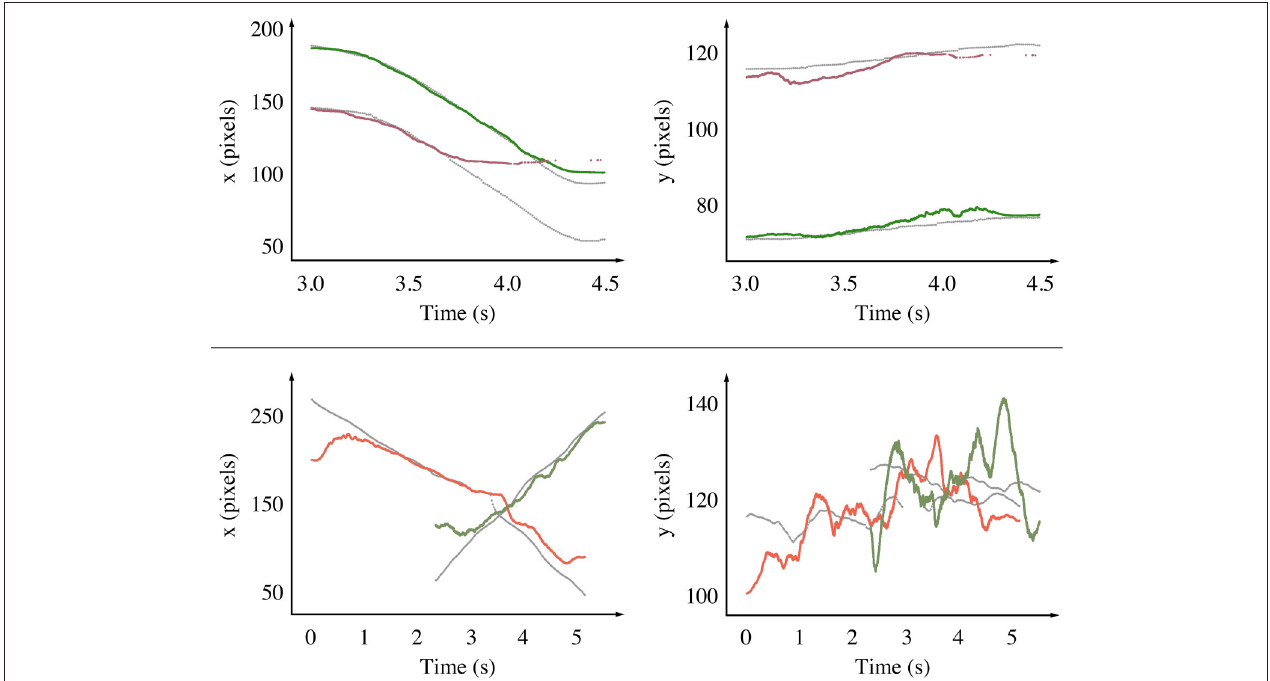
FIGURE 10 | We compare the estimated position of the tracked objects with the ground truth along the x and y axis as functions of time for the road signs experiment (Top) and the pedestrians experiment (Bottom) . The events’ timestamps are corrected to account for the delay induced by the mean-shift algorithm, effectively comparing dynamics rather than absolute values. Tracking is degraded near the edges, especially for the red stop sign ( Top , x axis, after 3.6 s), which is a consequence of our prototype’s optical aberrations. Since the pedestrians move along the x axis, motion along the y axis is relatively small, making the noise appear stronger.